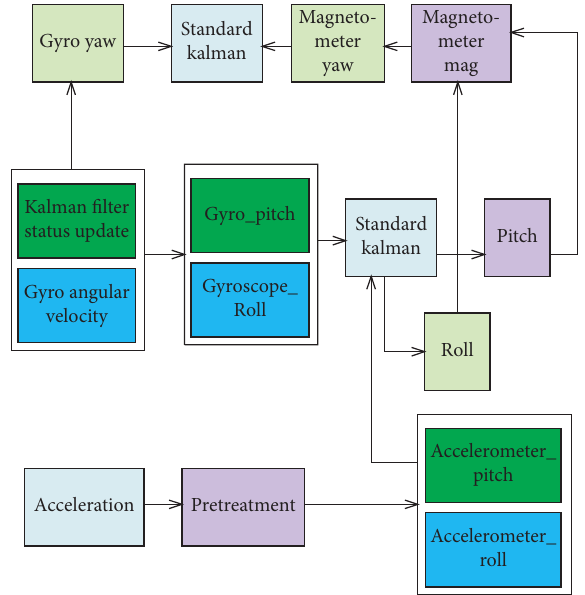
Figure 4: Two-step Kalman filtering principle